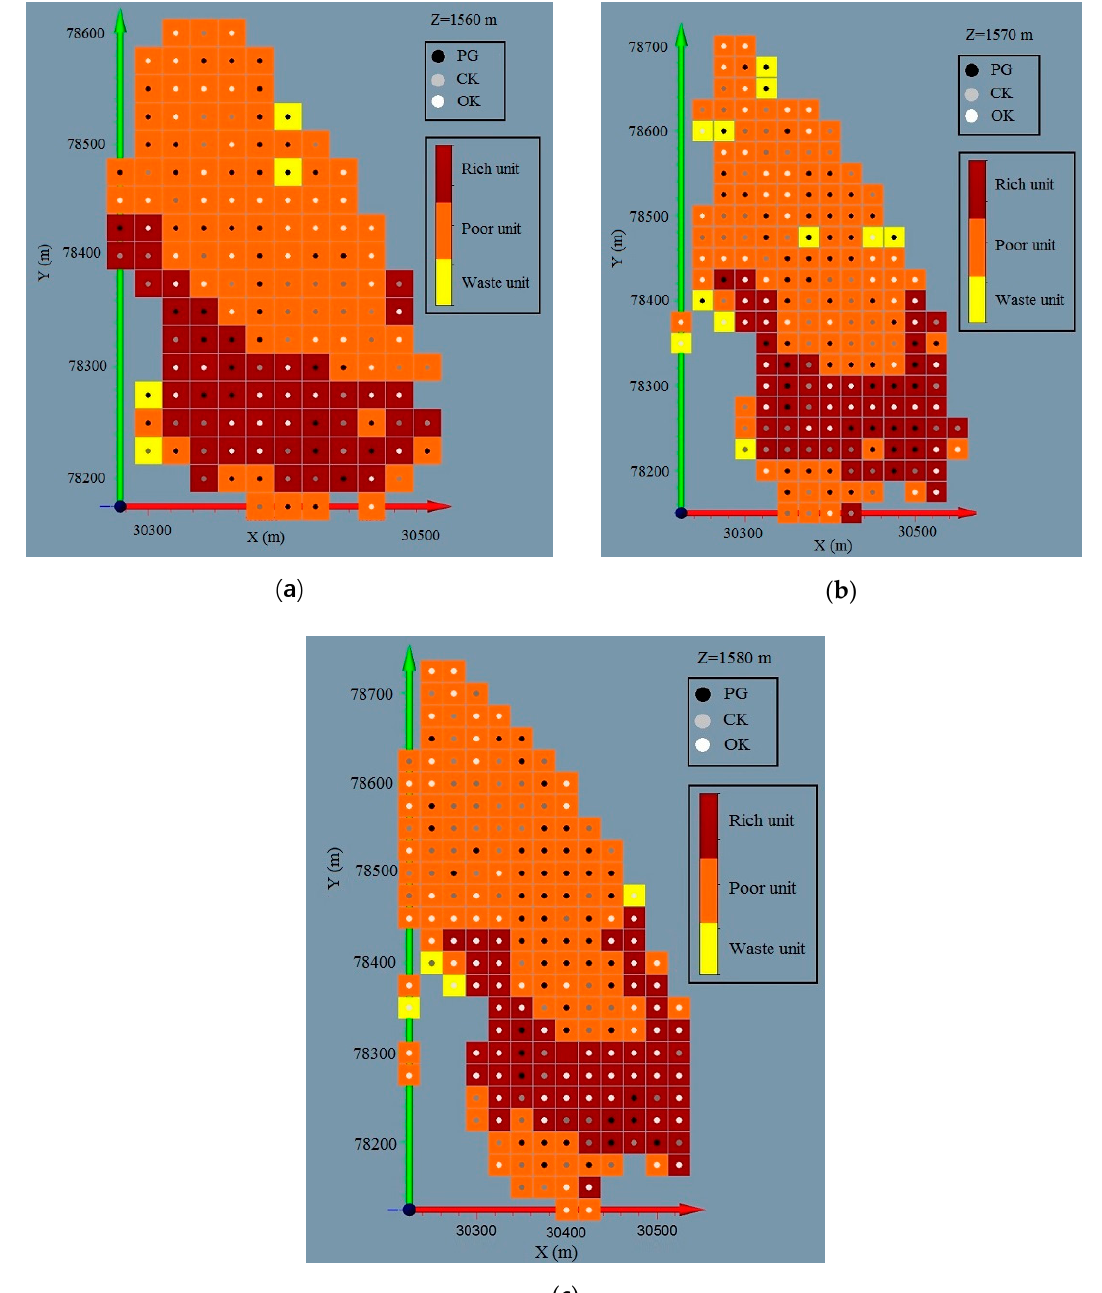
Figure 15. Maps of real block values obtained from mean of blastholes with optimum estimation method (e.g., three exploited levels). ( a ) is the horizontal section z = 1560 m, ( b ) is the horizontal section z = 1570 and ( c ) is the horizontal section z = 1580 m.